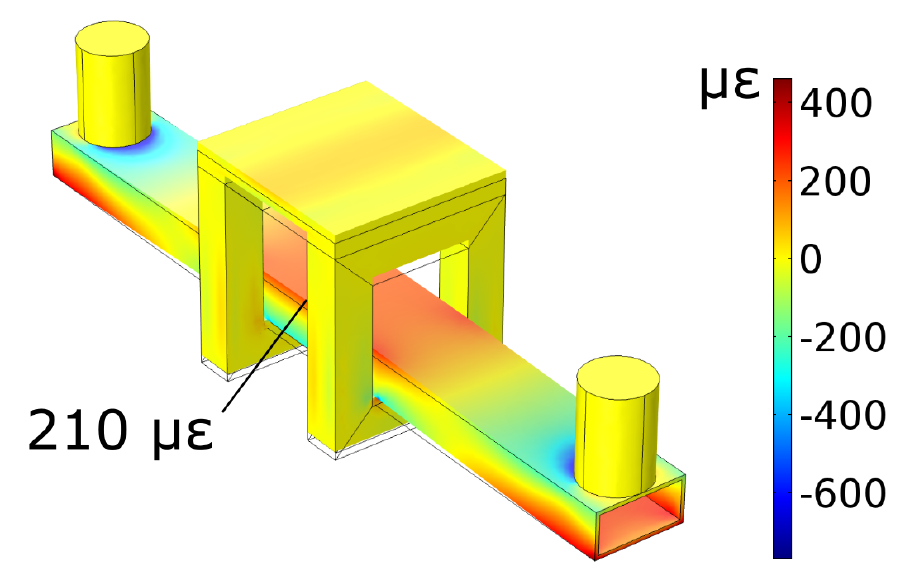
Figure 6. Stress distribution of the steel